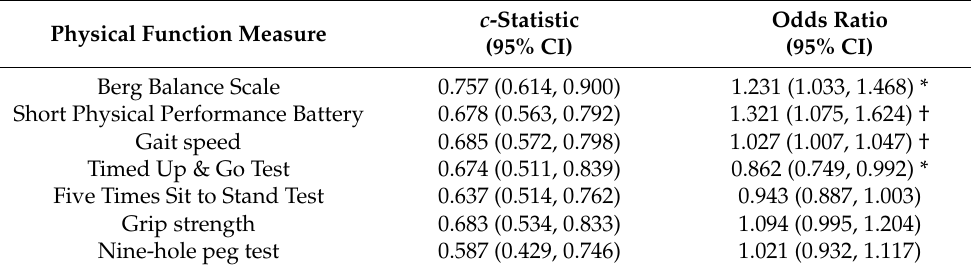
Table 3. Association between FOF and the physical function measures: summary of logistic regression